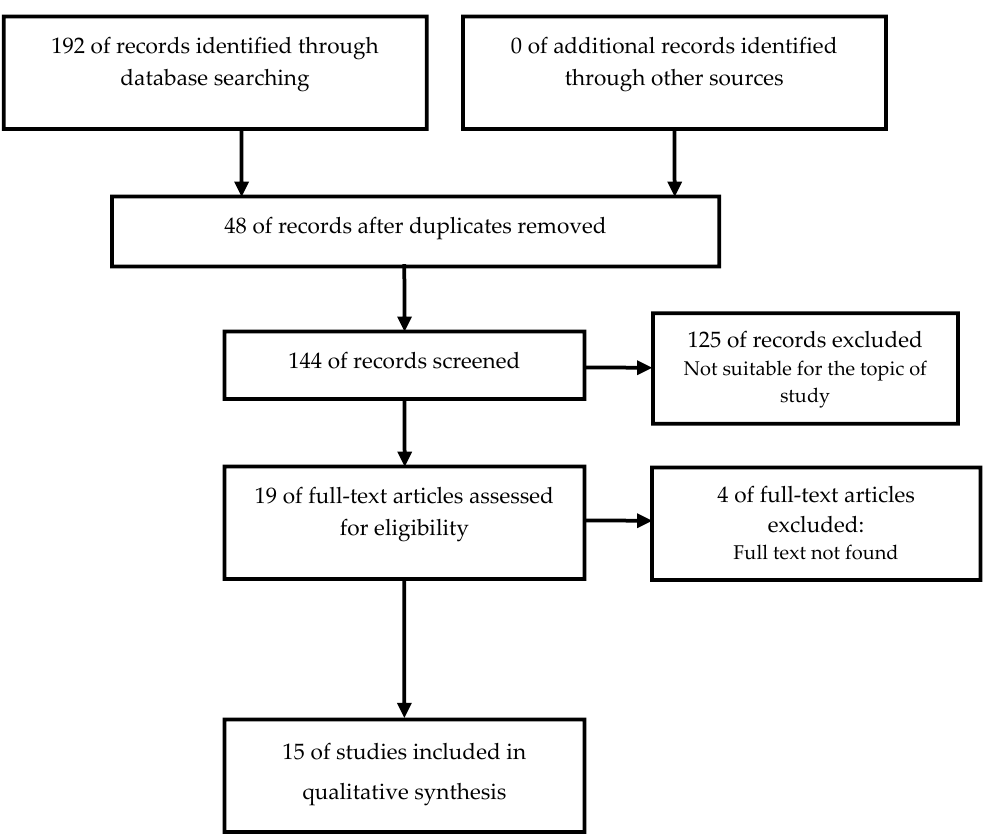
Figure 1. Identification and selection of studies according to Preferred Reporting Items for Systematic Reviews and Meta-Analyses (PRISMA statement [19].